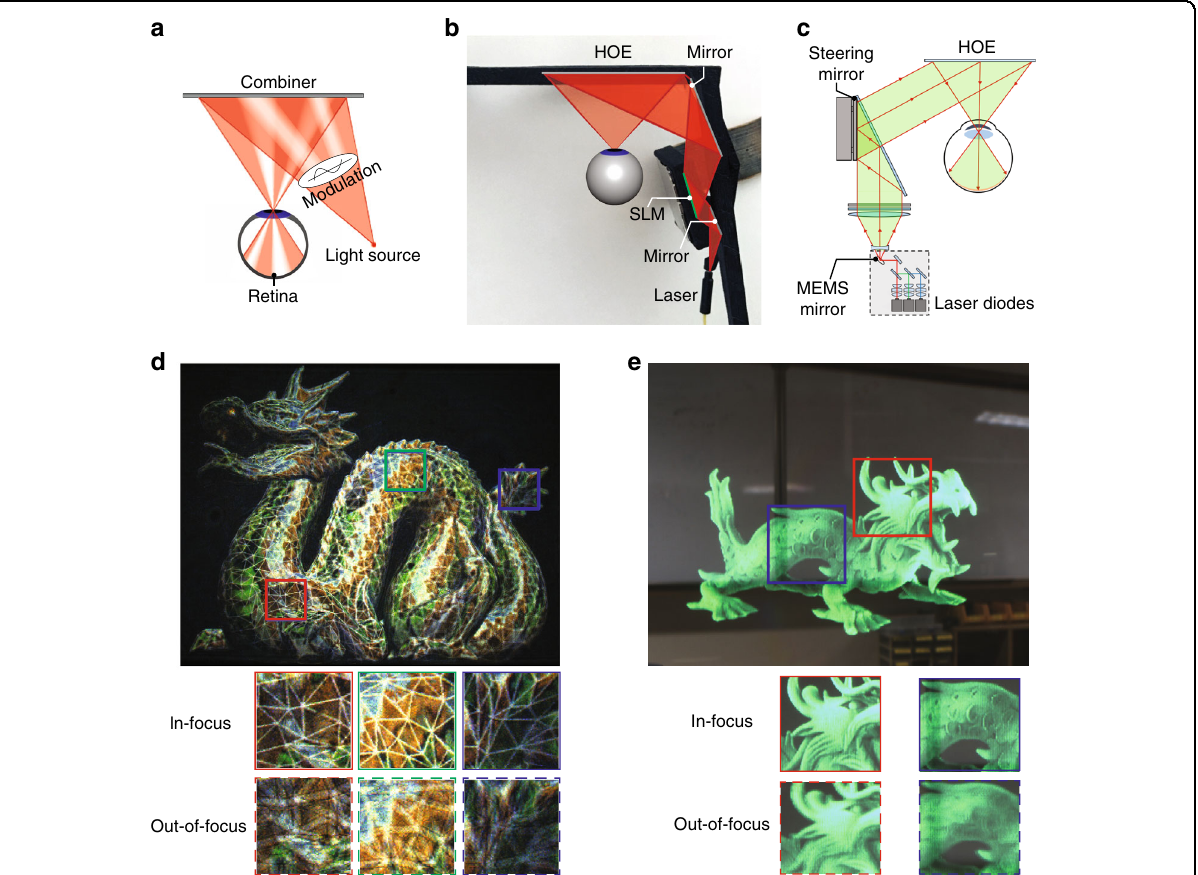
Fig. 9 Maxwellian-type AR Combiners. a Schematic of the working principle of Maxwellian displays. Maxwellian displays based on b SLM and laser diode light source and c MEMS-LBS with a steering mirror as additional modulation method. Generation of depth cues by d computational digital holography and e scanning of steering mirror to produce multiple views. Adapted from b, d ref. 143 and c, e ref. 167 under the Creative